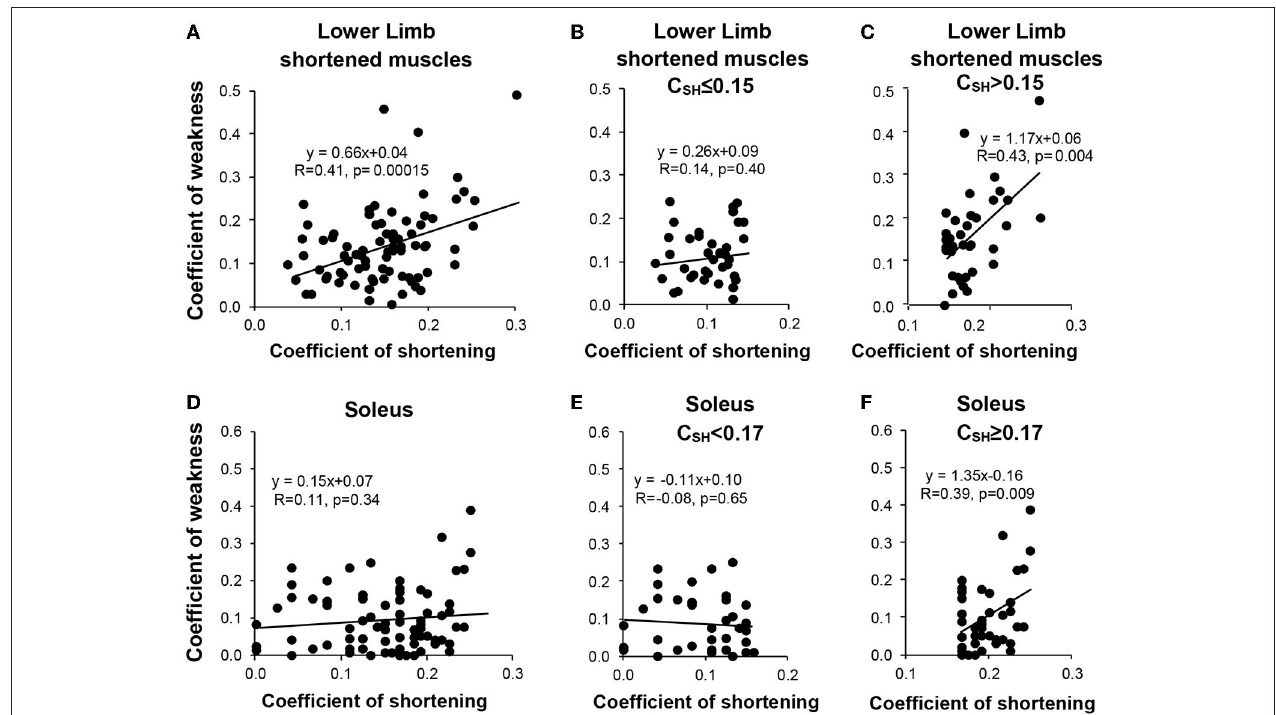
FIGURE 5 | Relationship between the muscular (shortening) and the neurological (weakness) disorders for the shortened muscle groups of the lower limb (sample of the muscle groups with mean CSH > 0.10, i.e., soleus, gastrocnemius, gluteus maximus, and rectus femoris) (A–C) and for the soleus muscle (D–F) . Left, the entire sample (A,D) ; middle, coefficients of shortening below the median (B,E) ; right, coefficients of shortening beyond the median (C,F)